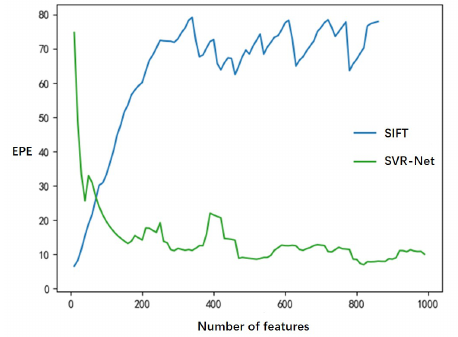
Figure 8. EPE at different numbers of feature